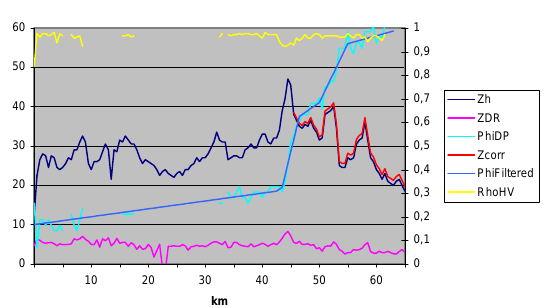
Fig. 8 : Comparison of rain rate estimates at 20 locations, together with value measured on the ground.